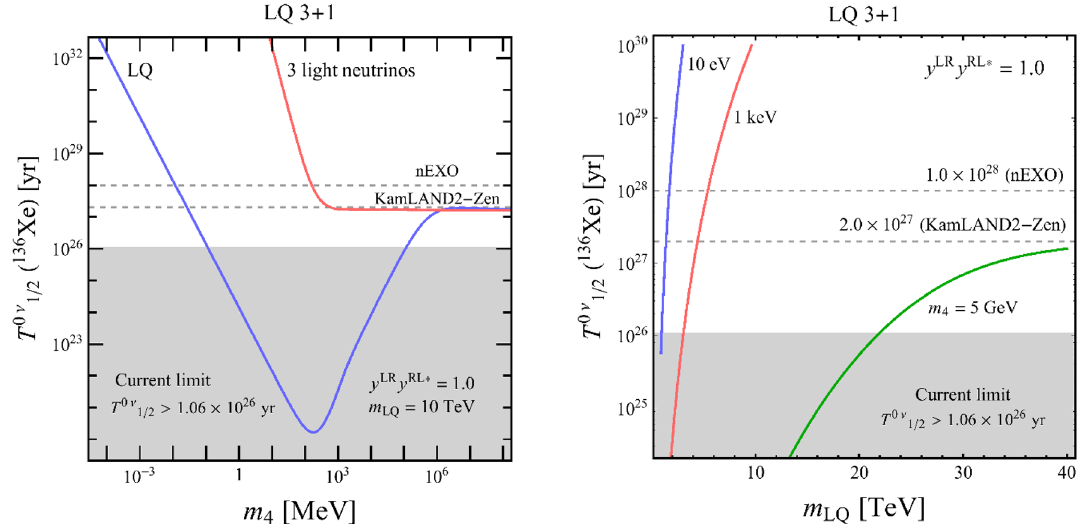
y RL (cid:3) = 1 : 0 and 11 12